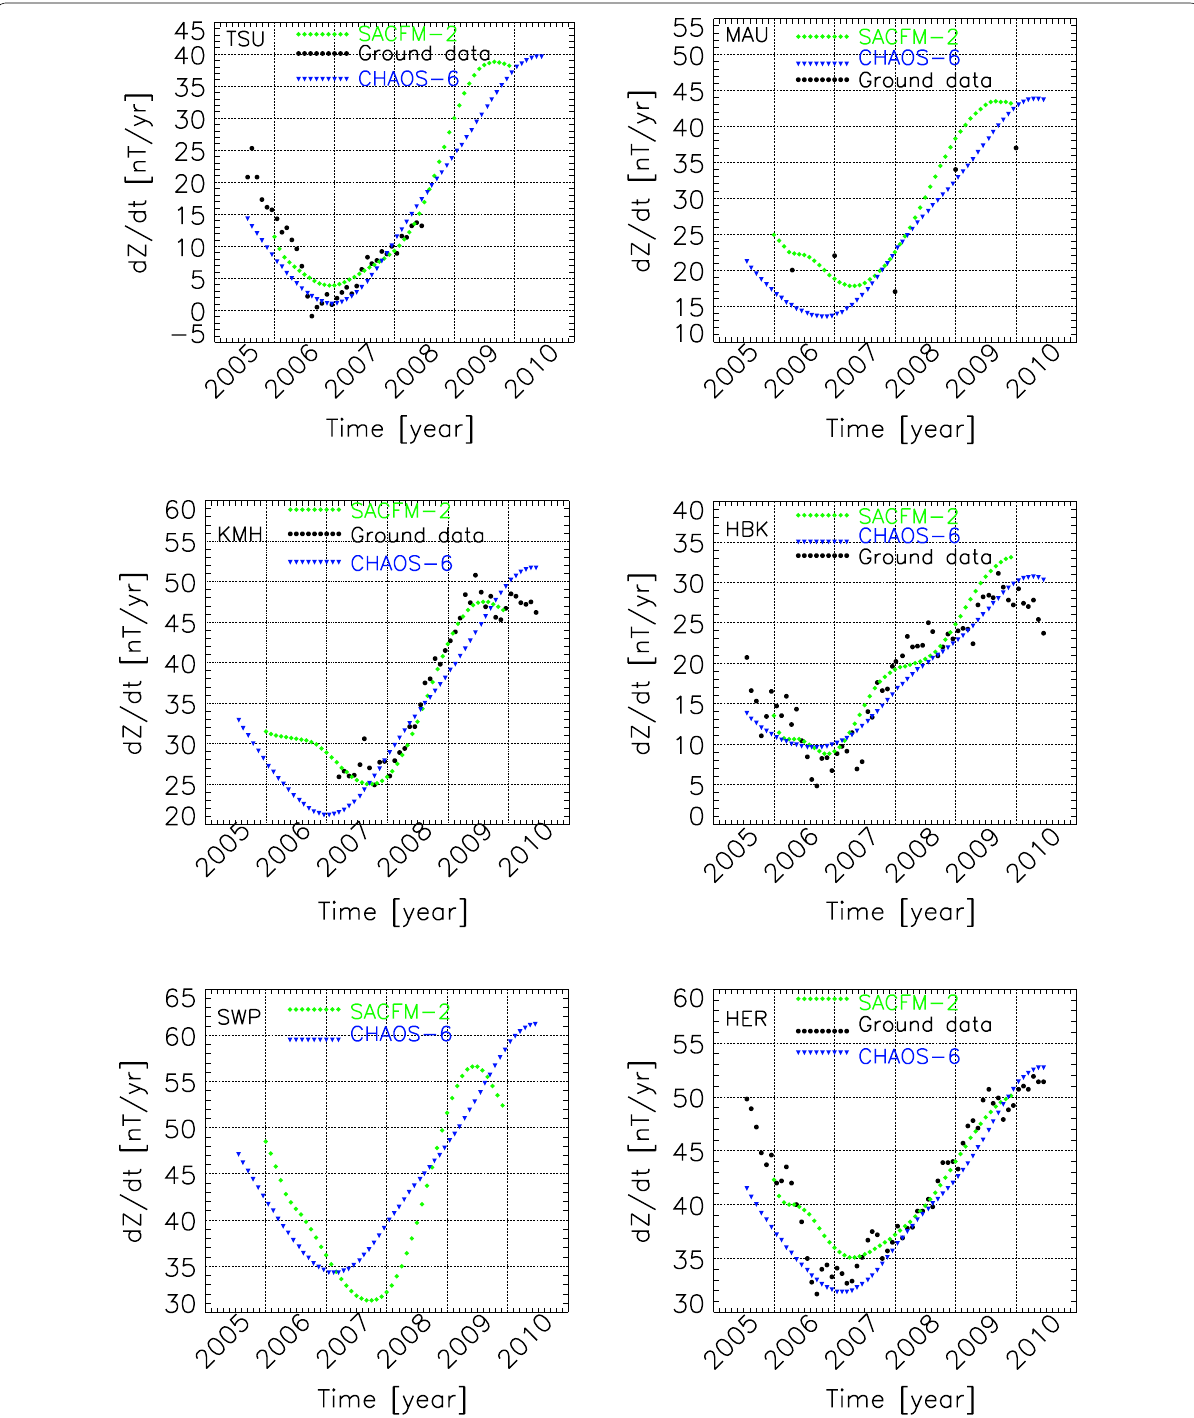
Fig. 7 Secular variation at TSU, KMH, MAU, SWP and HER for Z component. Secular variation of the Z component at the four observatories (data in black) and two additional reference points between 2005 and 2010 as given by SACFM-2 (green) and CHAOS-6 (blue)